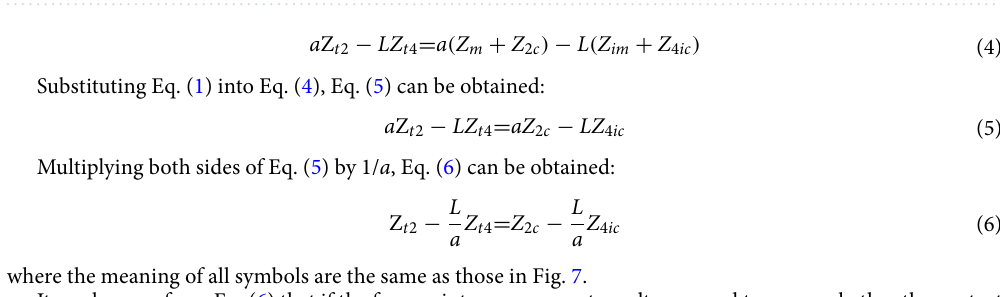
Figure 7. Nyquist plots of the four-point measurement with different conductive media between current electrodes and the sample (10 5 –10 7 Hz). ( a ) In the fog room curing condition. ( b ) Indoor curing